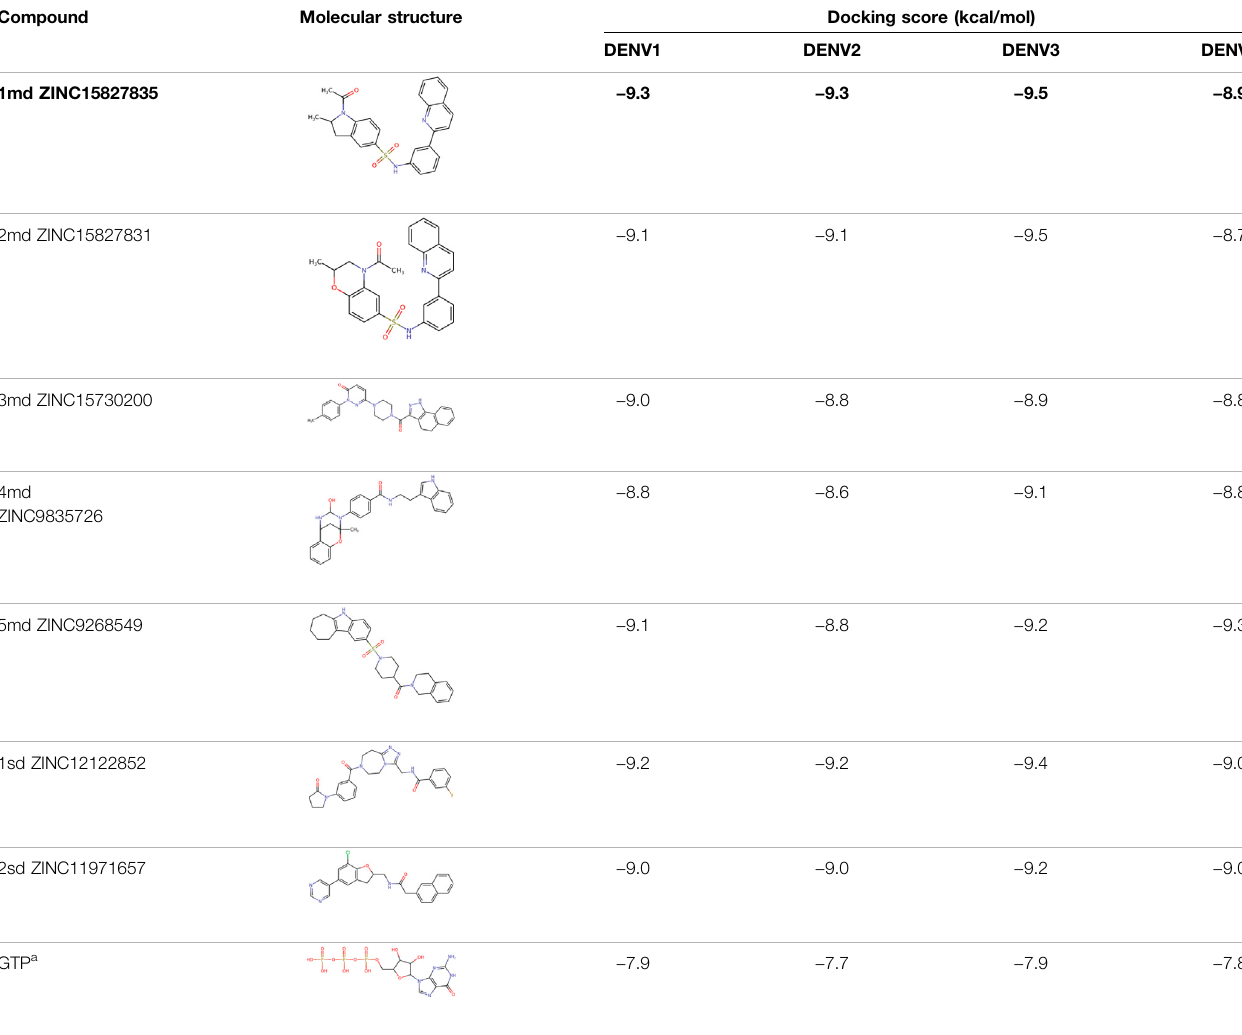
TABLE 2 | Best compounds obtained for the GTP-binding site of the four DENV serotypes. The best compound is highlighted in bold. Compound Molecular